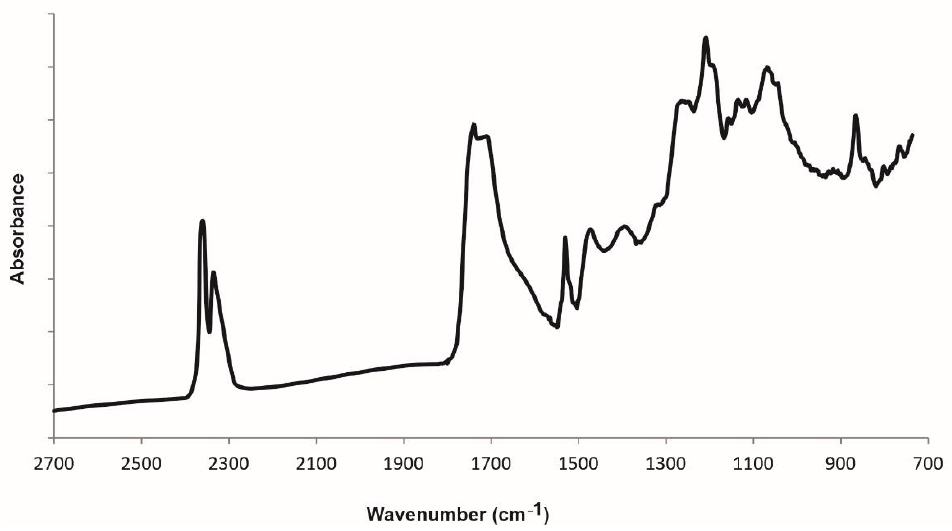
Figure 2. FTIR spectrum for CCWW-EWO-DGEBA particleboard.